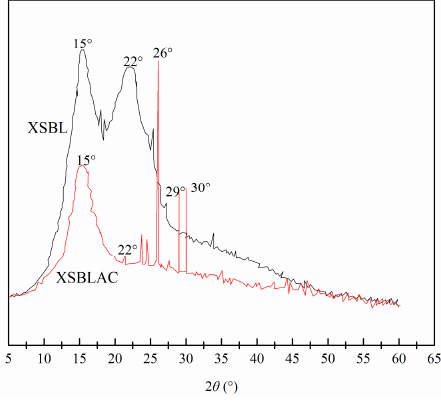
Figure 2. XRD patterns of raw XSBL and XSBLAC.